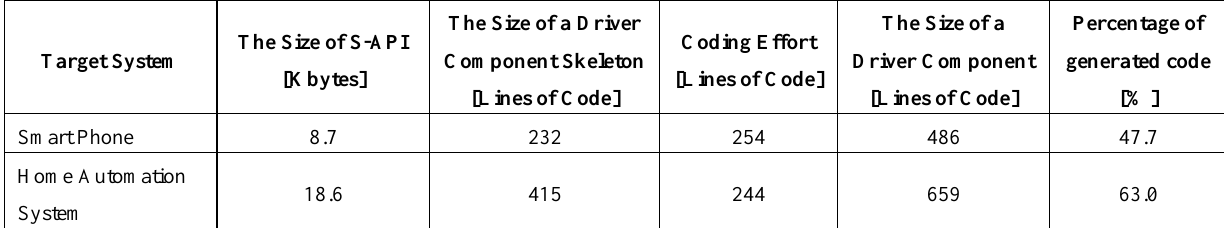
Table 2. The sizes of the implemented S-APIs and Driver